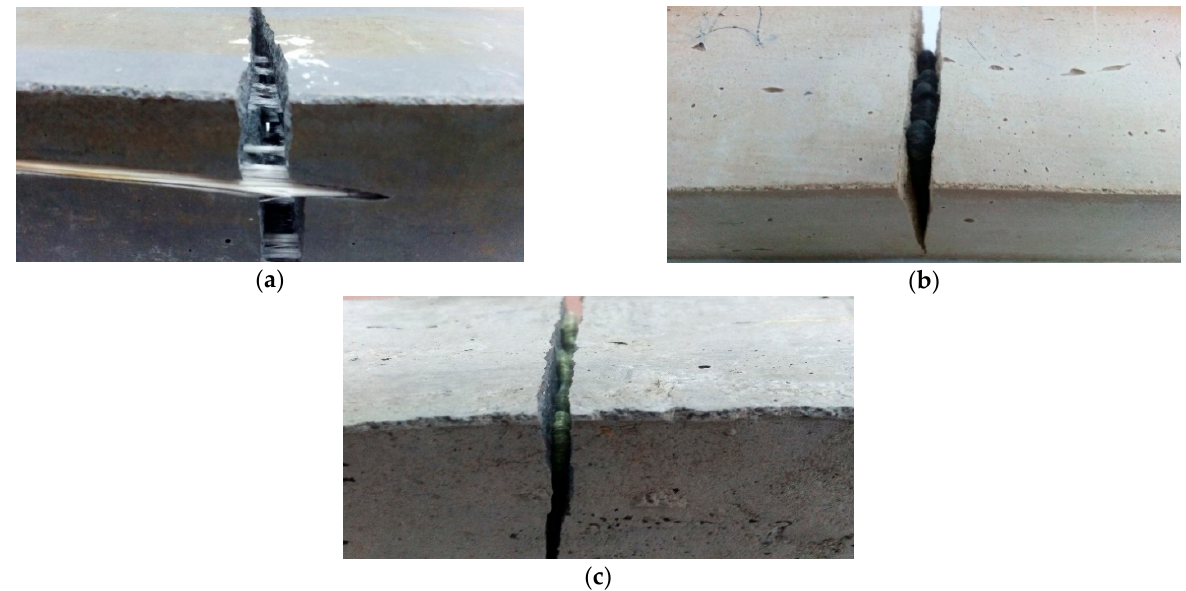
Figure 10. Behavior of different types of fibers in geopolymer composites: ( a ) fly ash composite reinforced with 1.0% glass fiber addition; ( b ) metakaolin-based composite reinforced with 2.0% carbon fiber addition; ( c ) fly ash composite reinforced with 2% addition of aramid fiber.